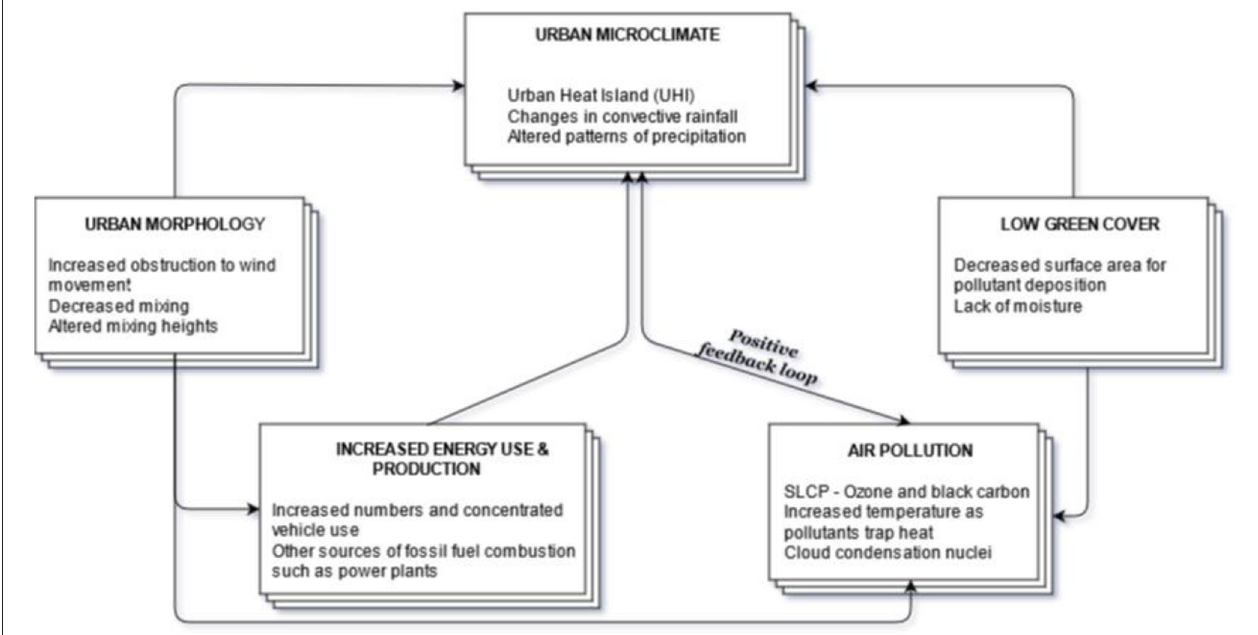
FIGURE 1 | Inter-linkages between changes in urban micro-climate and air pollution.